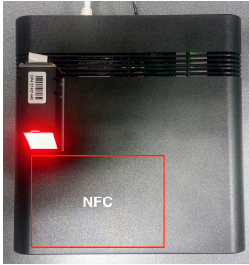
Figure 8. Top view of the first prototype.